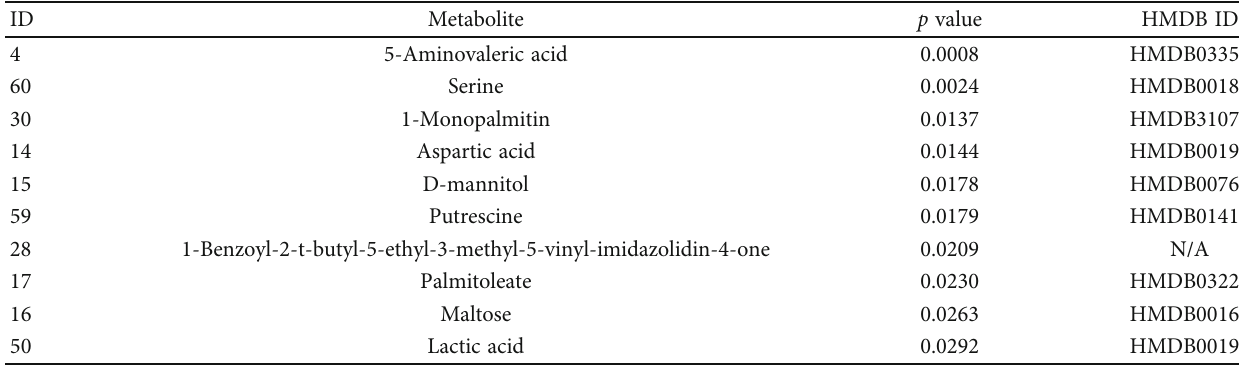
Table 2: Metabolites showing signi fi cant di ff erences with a p value < 0.05 according to t